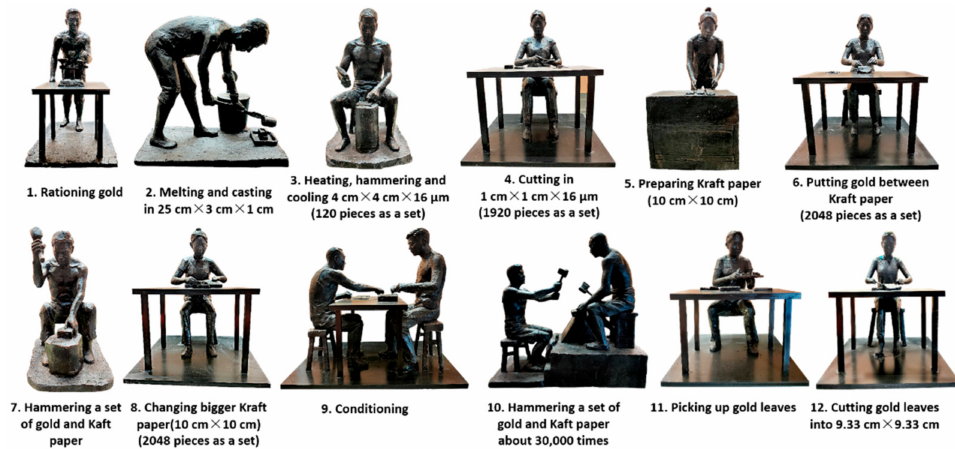
Figure 1. Schematic diagram of Chinese traditional gold leaf forging